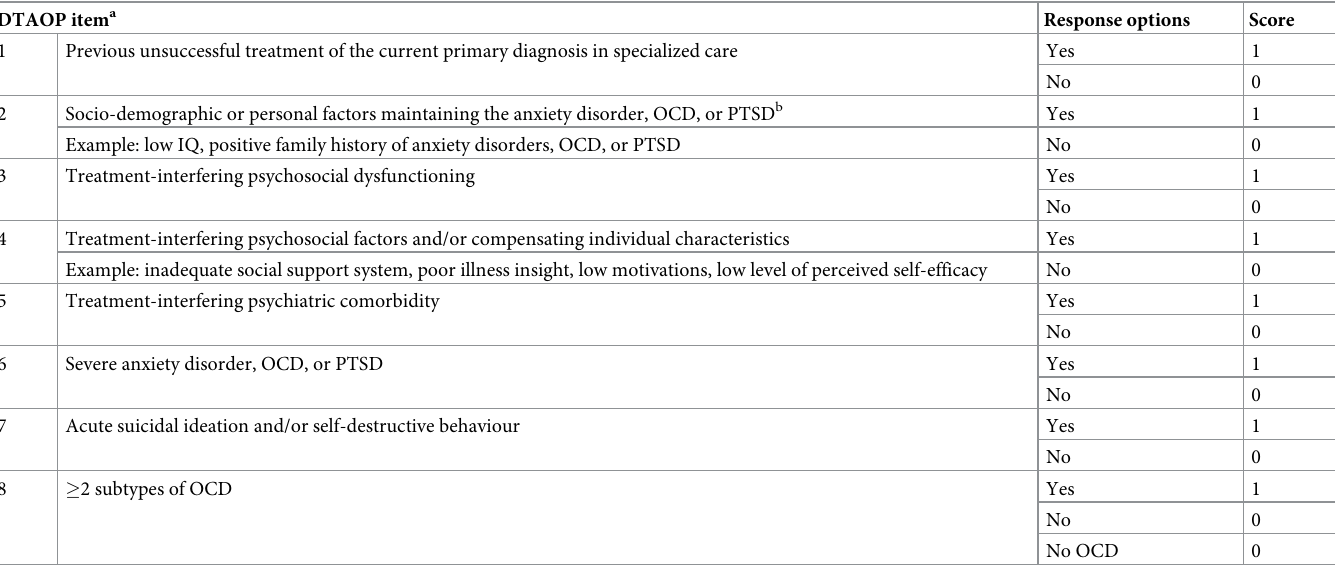
Table 1. The Decision Tool Anxiety Disorders, OCD and PTSD (DTAOP): Items, response options and scoring system. DTAOP item